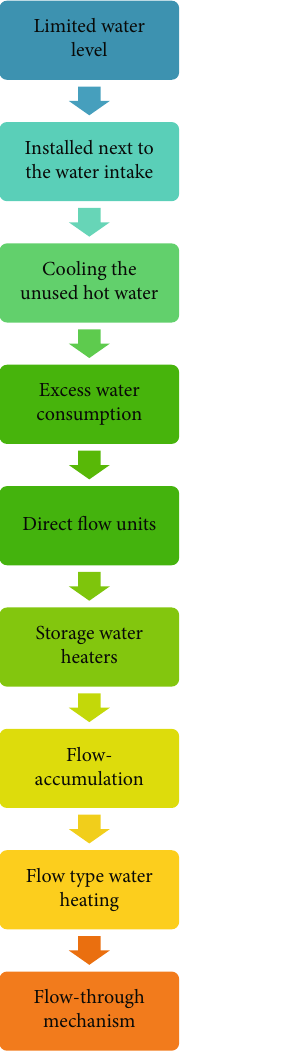
Figure 1: Proposed level